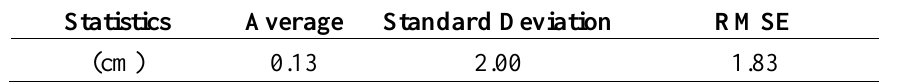
Table 10. Results of relative positional accuracy analysis for the Prudente de Morais